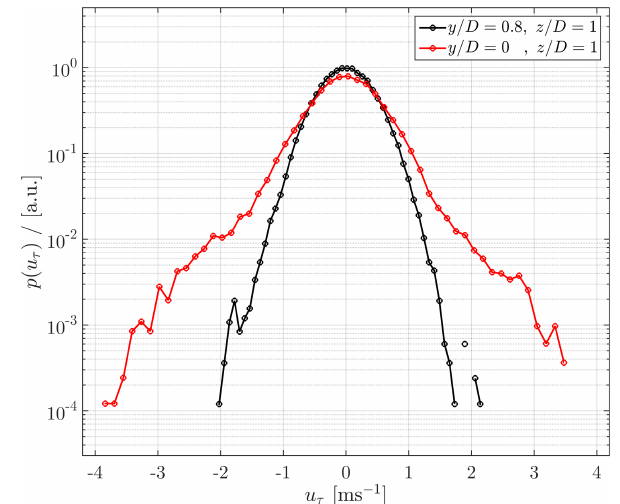
Figure 10. p ( u τ ) of the free stream at y/D = 0 . 8, z/D = 1 and at y/D = 0, z/D = 1, exemplary for the ForWind turbine.